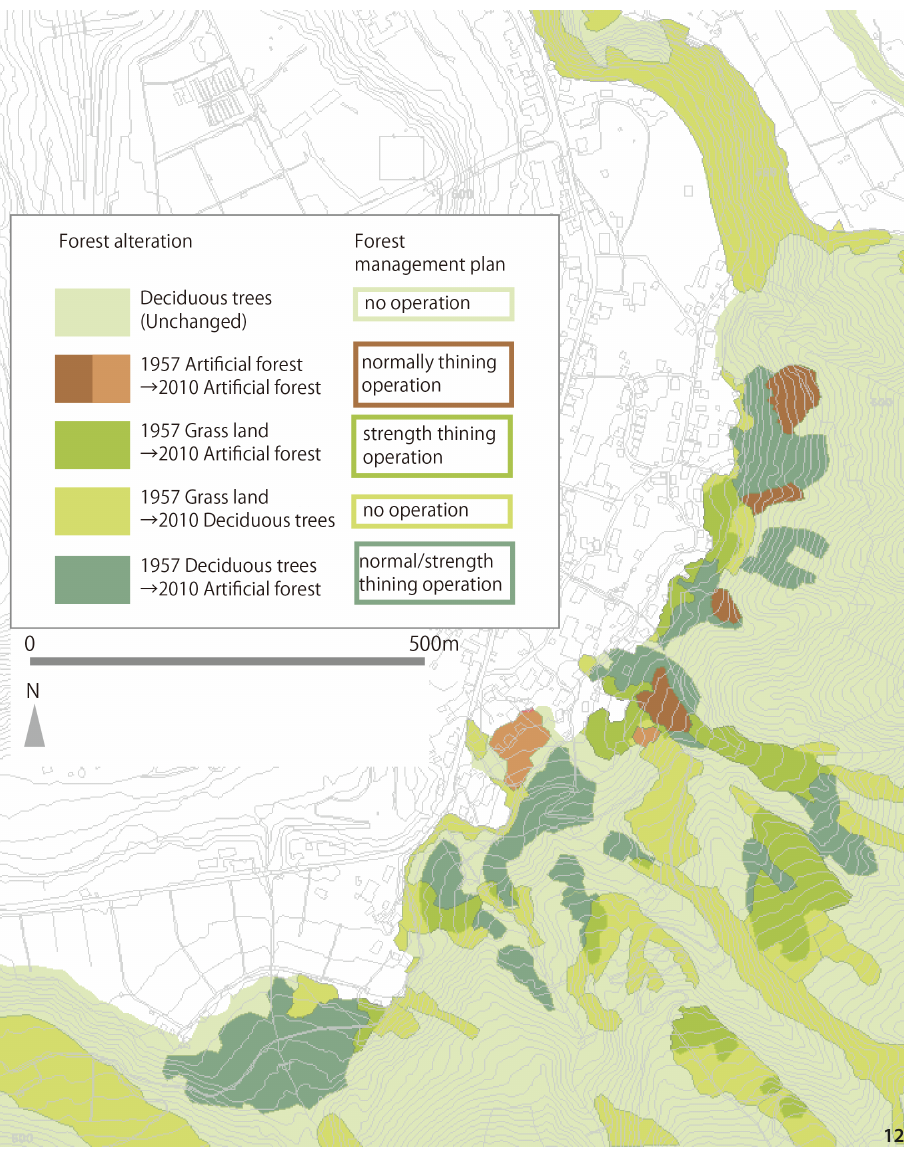
Figure 12 Transition of forest in Ogimachi Village (Source: the author).